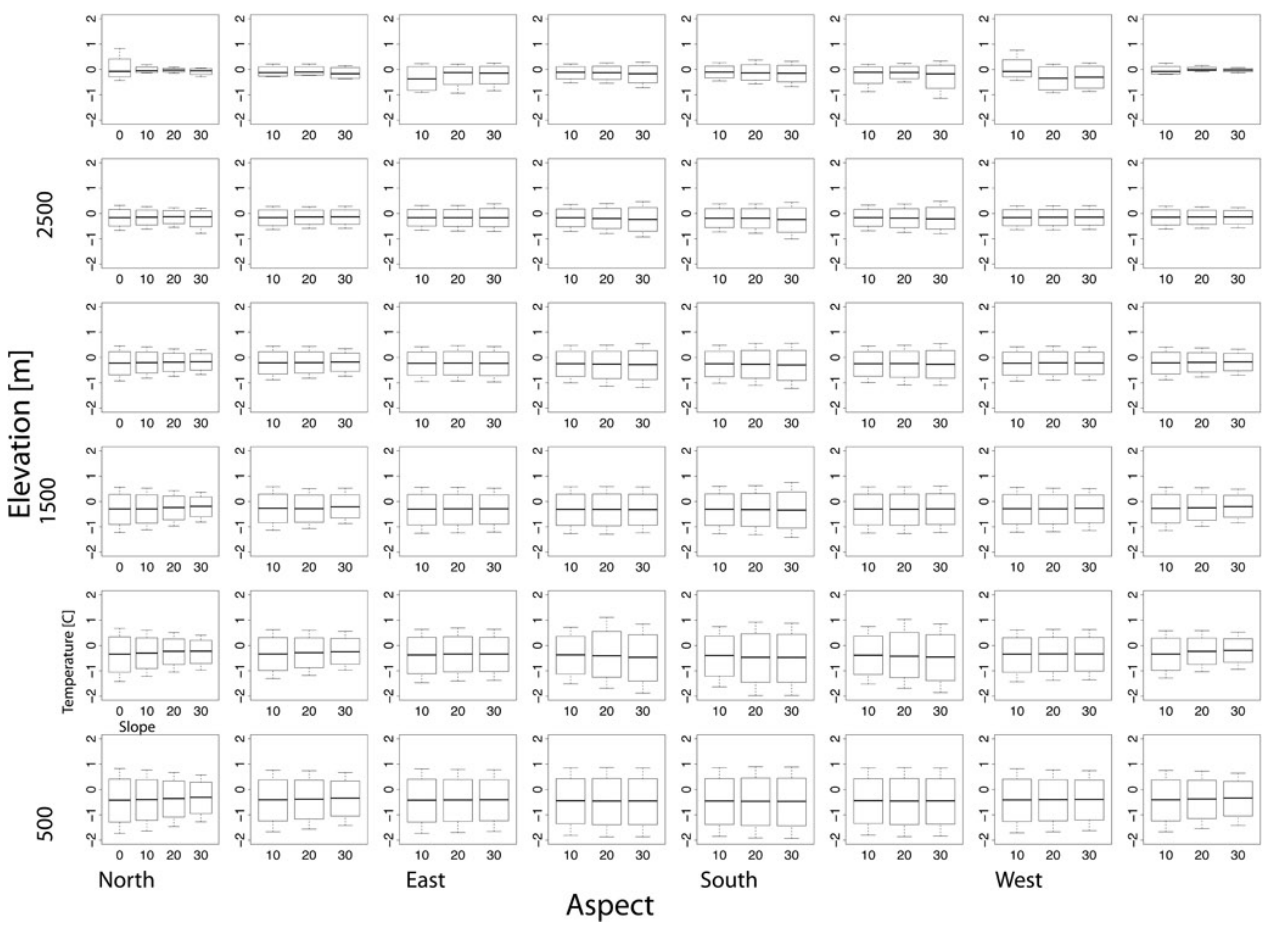
Fig. 7. Small multiple plots of normalized box plots of MAGT at 1m depth [ ◦ C], simulated at all topographic locations for different ground albedo values. The box plots represent the different model outputs. The length of the 95% uncertainty range of each box plot indicates the sensitivity to dry ground albedo at each